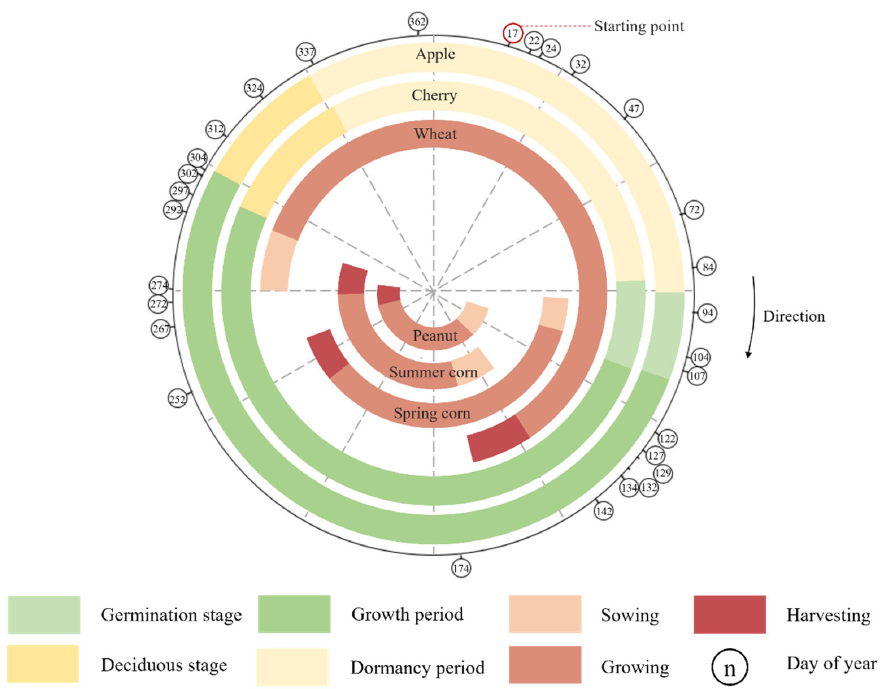
Figure 2. Crop phenological information and image acquisition time of regular time series.